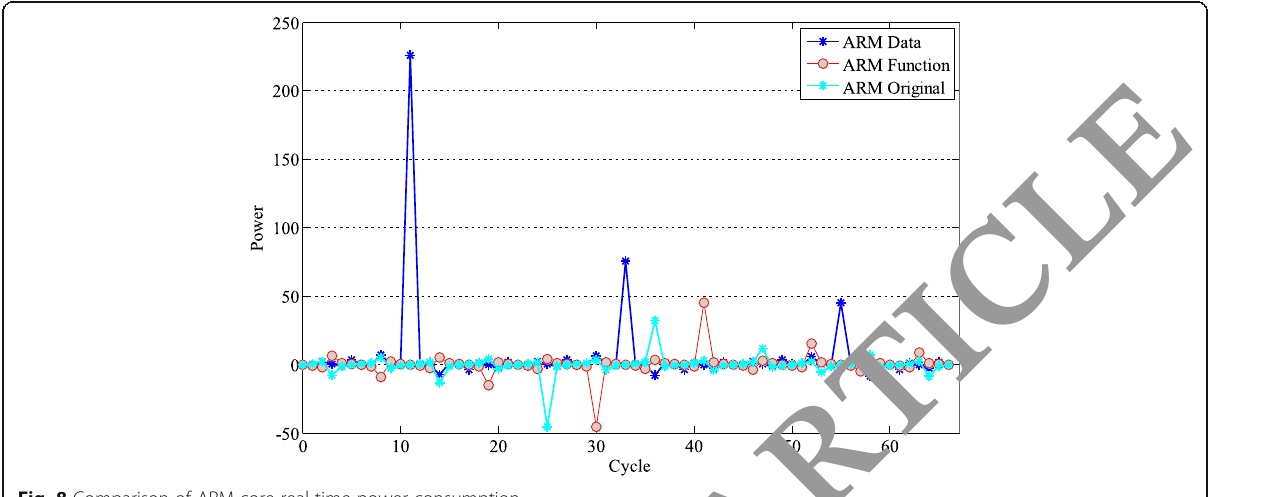
Fig. 8 Comparison of ARM core real-time power